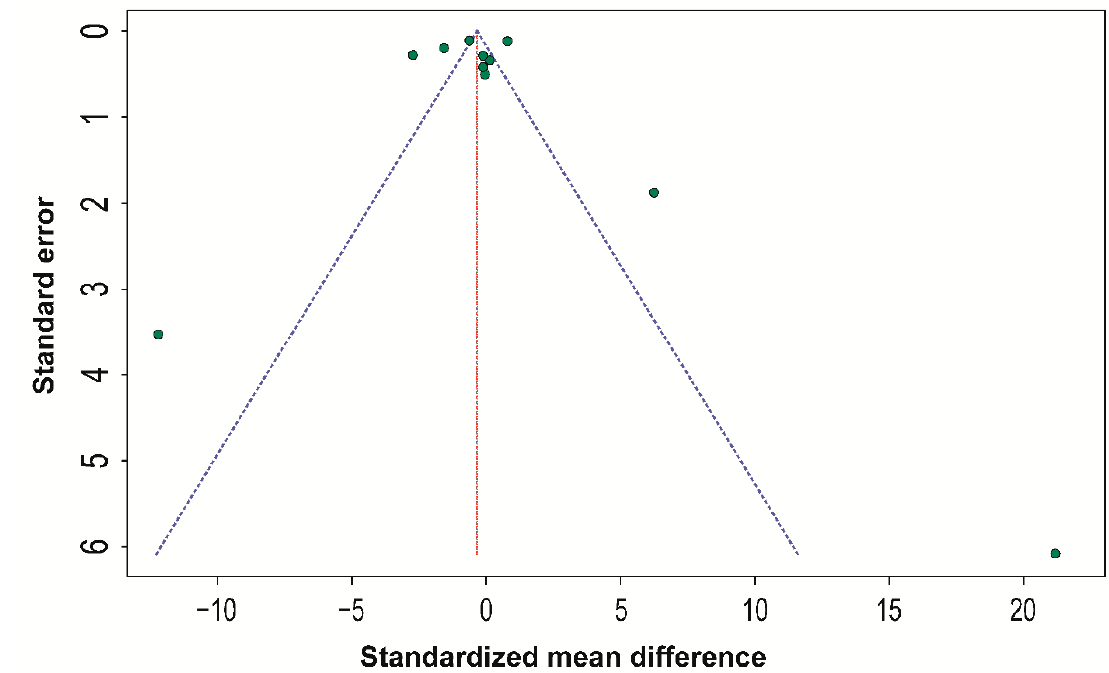
Figure 5. Funnel plot for the publication bias of all studies included in the meta-analysis.